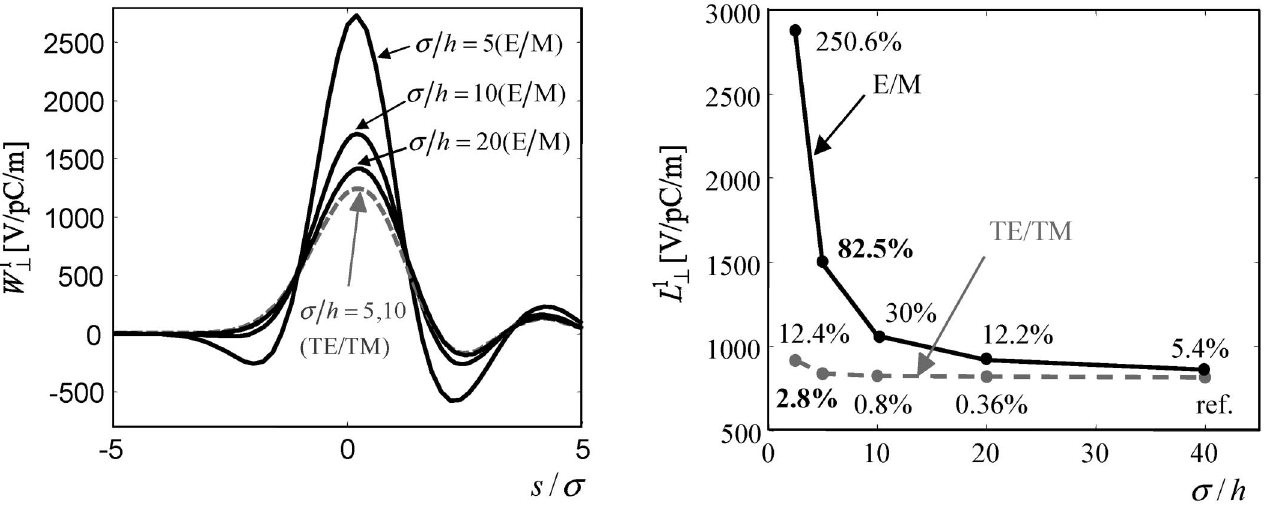
FIG. 6. The transverse dipole wake function (left) and loss factor (right) for the collimator with L (cid:5) 20 cm . The solid lines show the results for the E=M scheme (Yee’s scheme) and the dashed lines display the results for the TE/TM scheme. The relative errors are given regarding the reference value (marked as ‘‘ref.’’ on the graphs) calculated by the TE/TM method with the finest